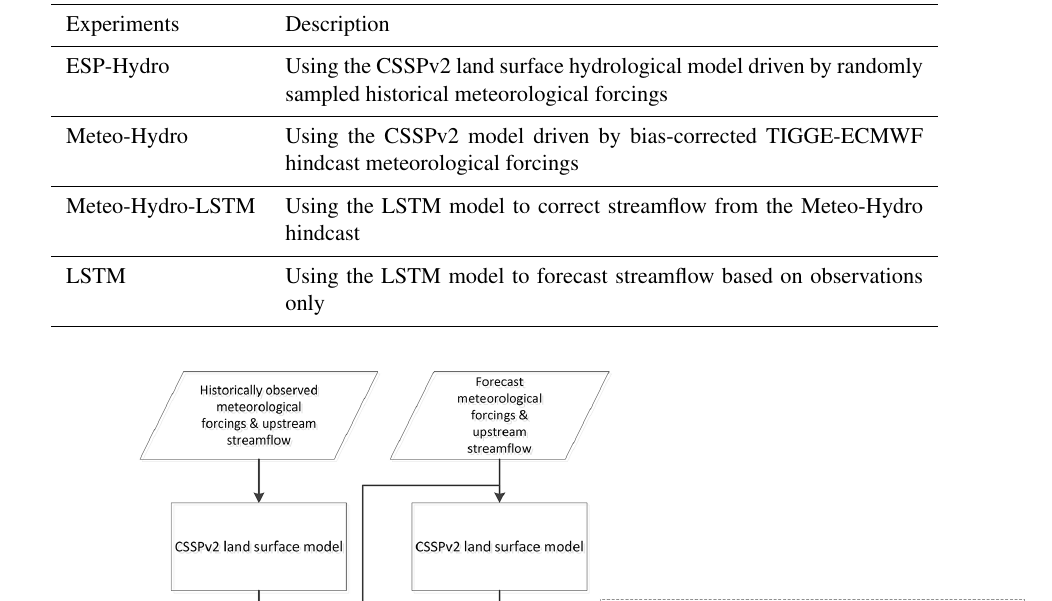
Table 4. Experimental design in this study.